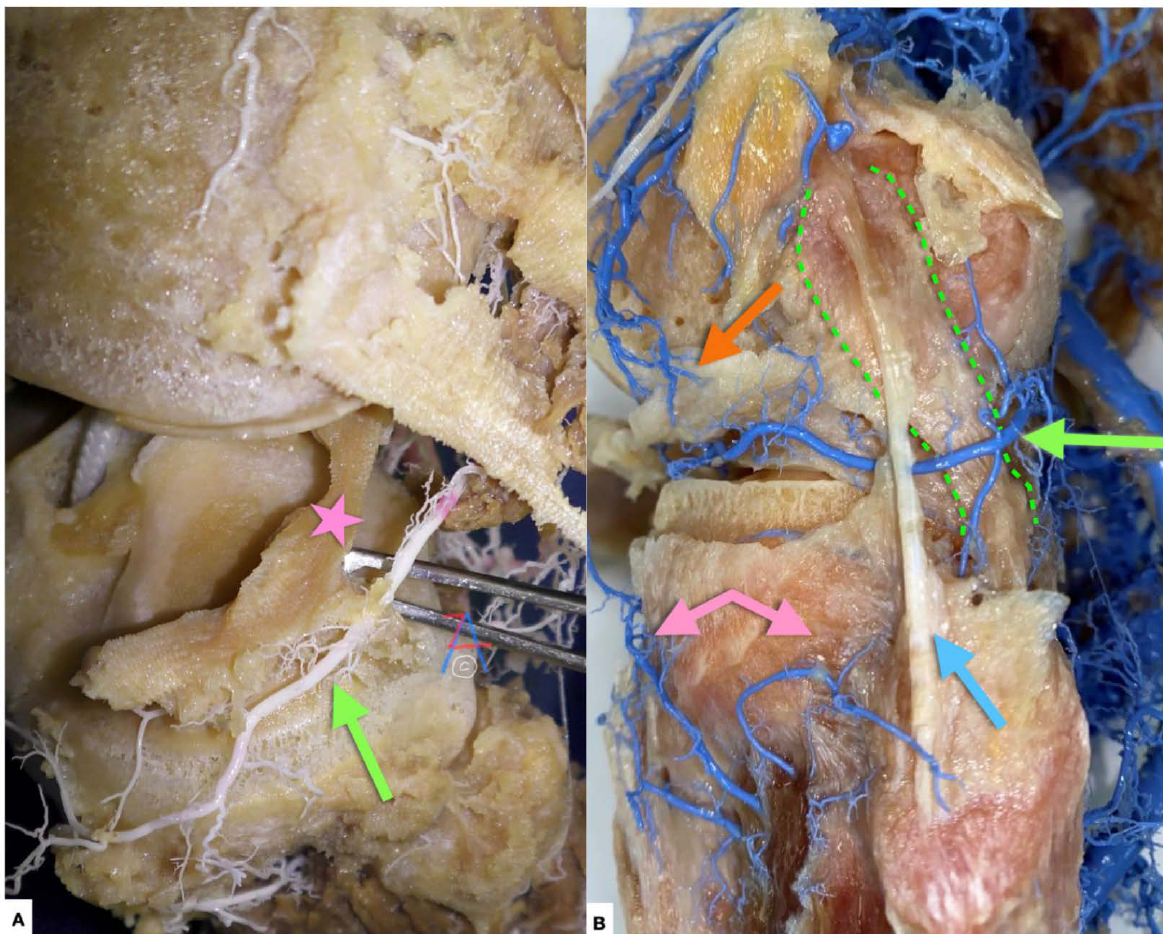
Figure 10. ( A ) Left knee, lateral view. Green arrow: lateral inferior genicular artery, pink star: lateral meniscus. ( B ) The lateral inferior genicular artery (green arrow) provides the blood supply of the peripheral portion of the lateral meniscus, with anastomoses from final branches of the lateral superior (orange arrow) geniculate artery and recurrent branches from the anterior tibial artery (pink arrows). The anterior and posterior horns of the lateral menisci appear more vascular than the bodies of the menisci, as documented by Day et al. [11]. The popliteus tendon (green dotted line) intervenes posteriorly between the lateral meniscus and the inferior lateral genicular artery. This might contribute to a relative avascular zone in the area of the lateral meniscus adjacent to the popliteus tendon, as observed by Day et al. [11]. Light blue arrow: lateral collateral